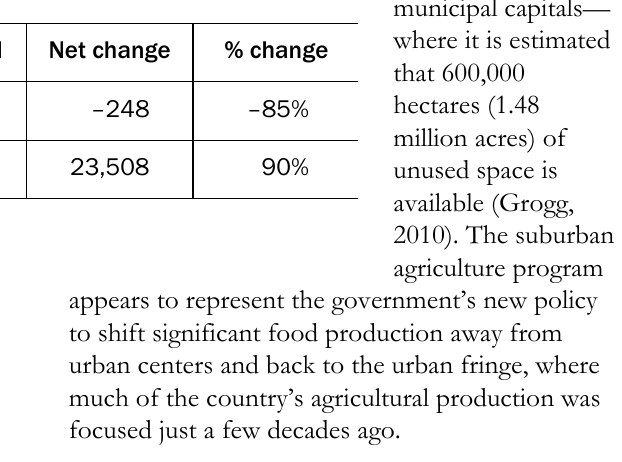
Table 2: Change in the Number of Urban Gardens by Type in Havana,